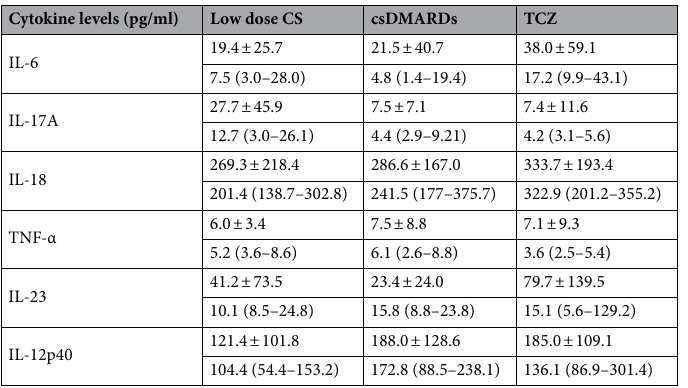
Table 2. Serum cytokines in RA female patients` treatment subgroups. Data are presented as mean ± SD and median (IQR). CS corticosteroids, csDMARDs conventional synthetic disease modifying anti-rheumatic drugs, IQR interquartil range, TCZ